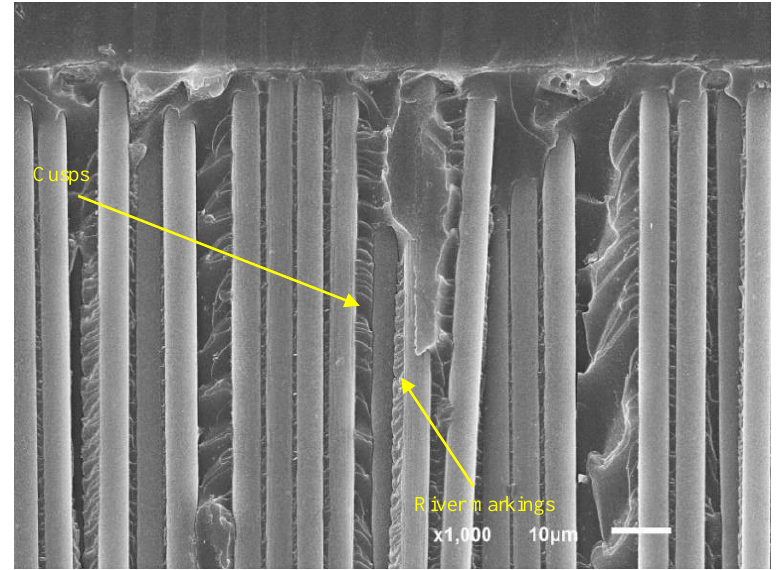
Figure 12. SEM micrographs of an ADCB fatigue specimen showing the presence of cusps and river markings.